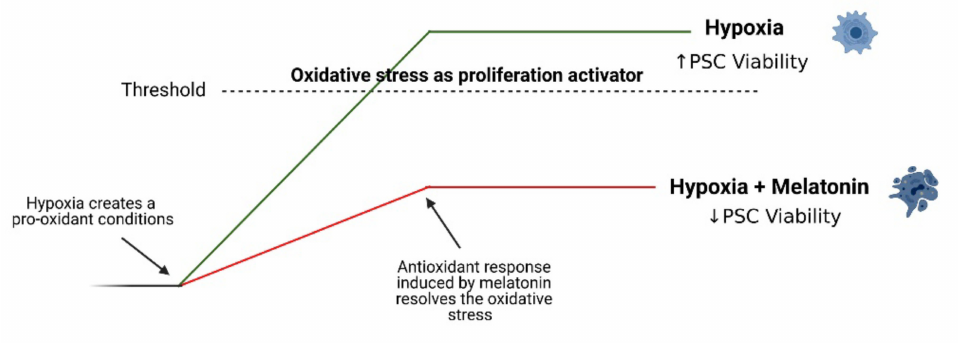
Figure 8. Potential involvement of oxidative stress-related cellular responses in melatonin effect on PSCs physiology. The hostile pro-oxidative environment created by hypoxia could induce a certain level of unresolved oxidative, which might be responsible for the development of potential fibrosis in the pancreas (green trace). On its side, melatonin reinforces the antioxidant defenses that could tend to counteract the production of ROS that we have detected under hypoxia. The consequent higher level of antioxidant enzymes that is achieved could resolve the oxidative stress induced by hypoxia and could decrease the development of fibrosis (red trace). Figure created with BioRender software (BioRender.com accessed on 1 February